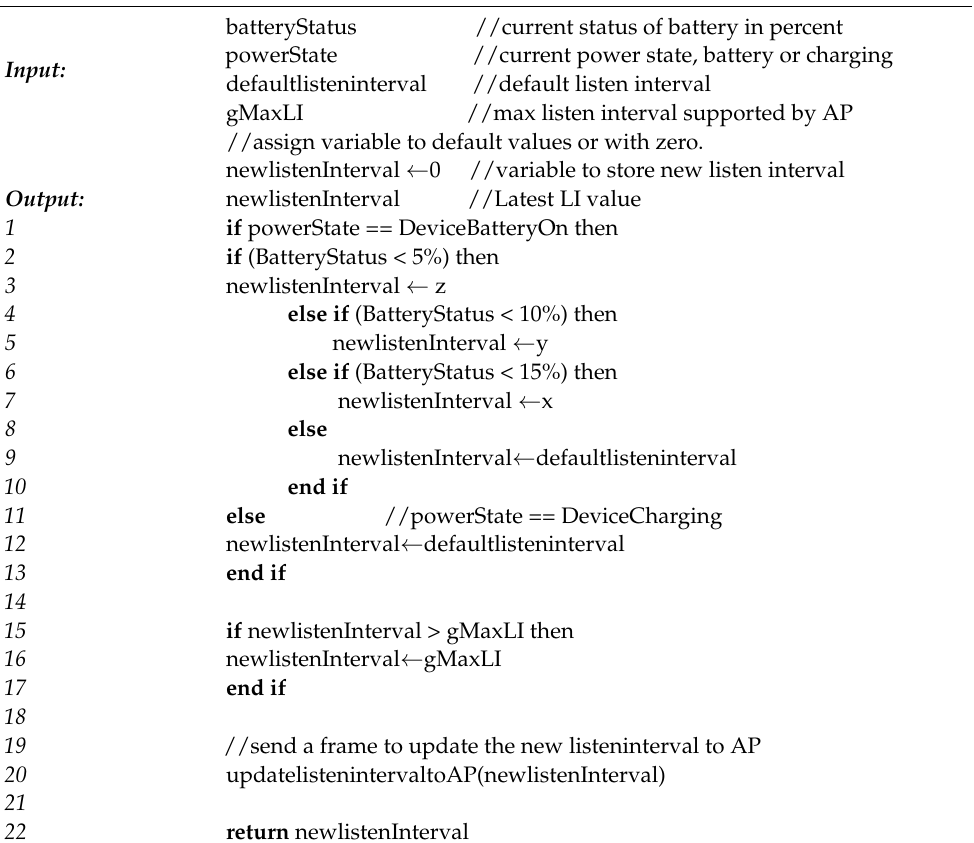
Algorithm 1: STA Dynamic Battery